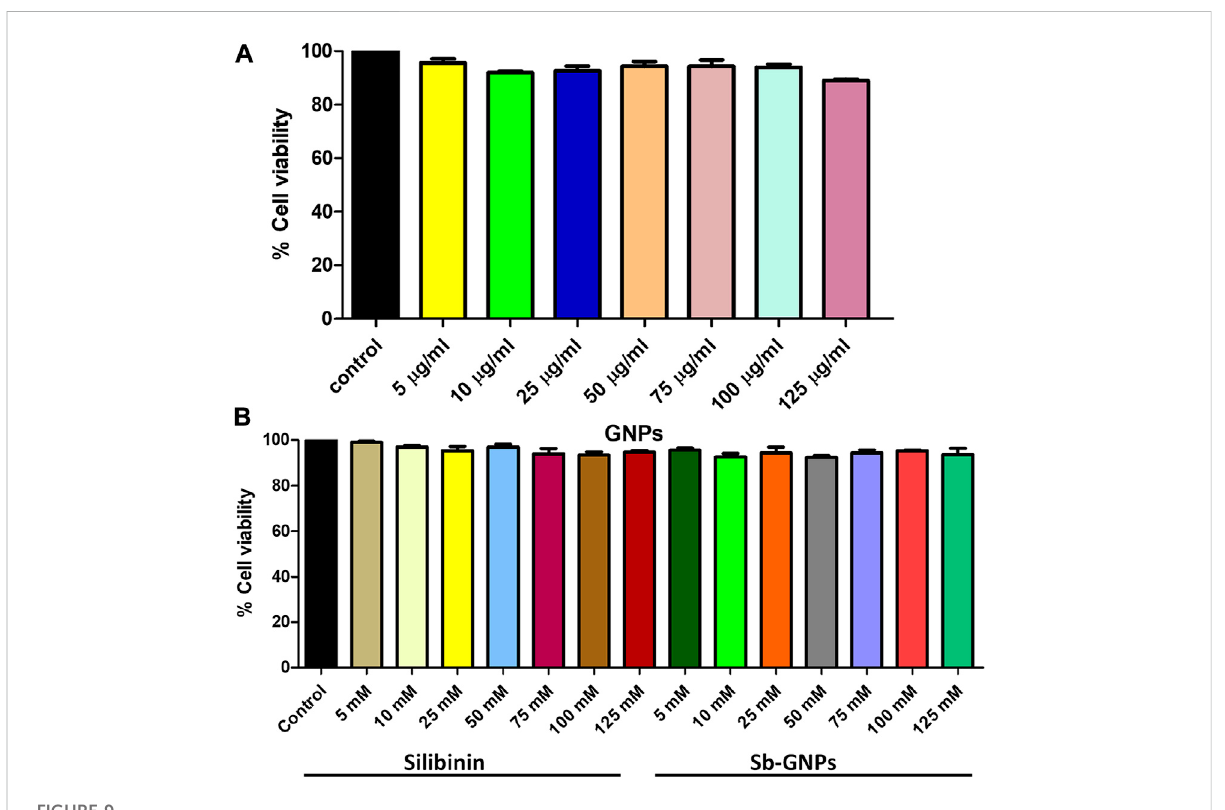
FIGURE 9 Effect of (A) Free GNPs; (B) Silibinin and Sb-GNPs against normal cell viability